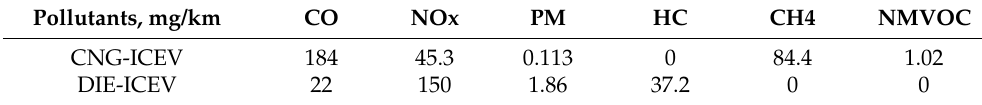
Table A3. Distance-specific TTW pollutant emissions.